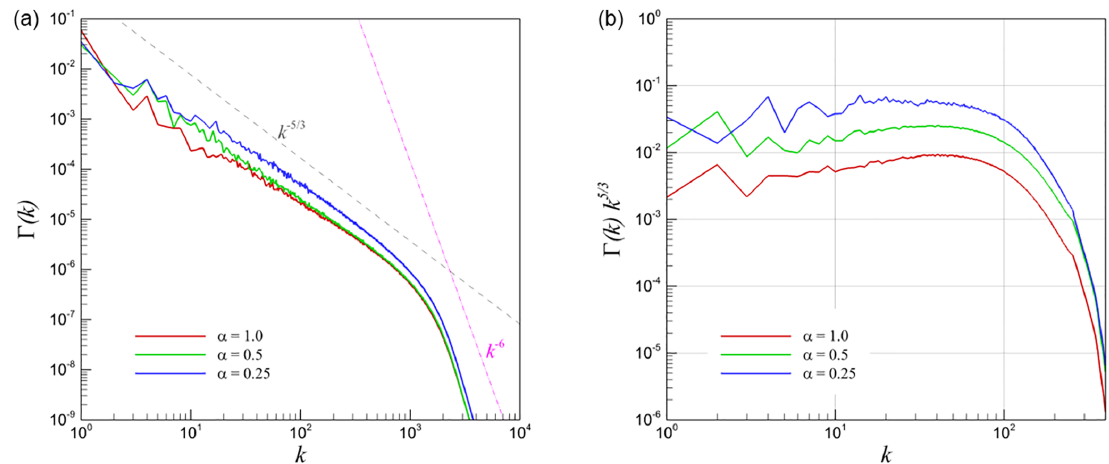
Figure 18. Angle-averaged density power spectra for 2-D KHI turbulence (a) and its compensated form (b) .